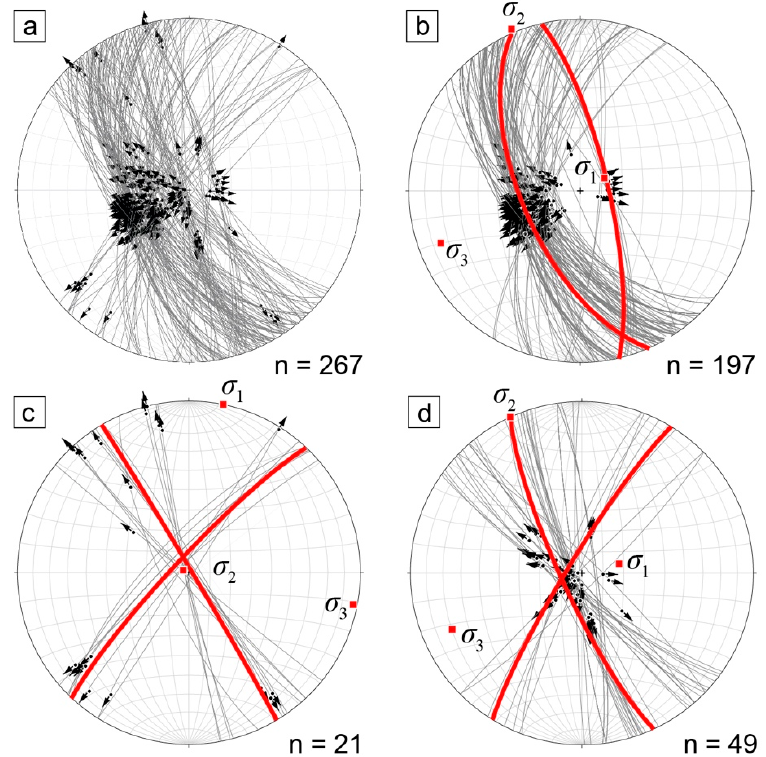
Figure 8. Stereonet showing the structural data of fault plane and slickenline pairs measured in the field. Planes are represented by great circles, whereas slickenlines and slip directions are represented by points and arrows on the corresponding great circle. ( a ) Plot of all 267 measurements. ( b ) Normal faults have moderately to steeply dipping planes, 188 are W-dipping and 9 are E-dipping. The average normal fault plane for west-dipping faults (red great circle) strikes 157 ◦ with a dip of 65 ◦ with east-dipping faults on average striking 347 ◦ and dipping 78 ◦ . The maximum principal stress axis is steeply plunging whereas the minimum and intermediate principal stress axes are oriented sub-horizontally. ( c ) Strike-slip faults have steeply dipping planes, 16 are W-dipping and 5 are E-dipping. The average strike-slip fault plane (red great circle) strikes 330 ◦ with a dip of 86 ◦ . An average conjugate plane is determined to strike 223 ◦ and dip 82 ◦ . The intermediate principal stress axis is vertical whereas the minimum and maximum principal stress axes are oriented horizontally. ( d ) Oblique faults have moderately to steeply dipping planes, 42 are W-dipping and 7 are E-dipping. The average oblique fault plane (red great circle) strikes 152 ◦ with a dip of 85 ◦ . The maximum principal stress axis is sub-vertical and the minimum and intermediate principal stress axes are oriented